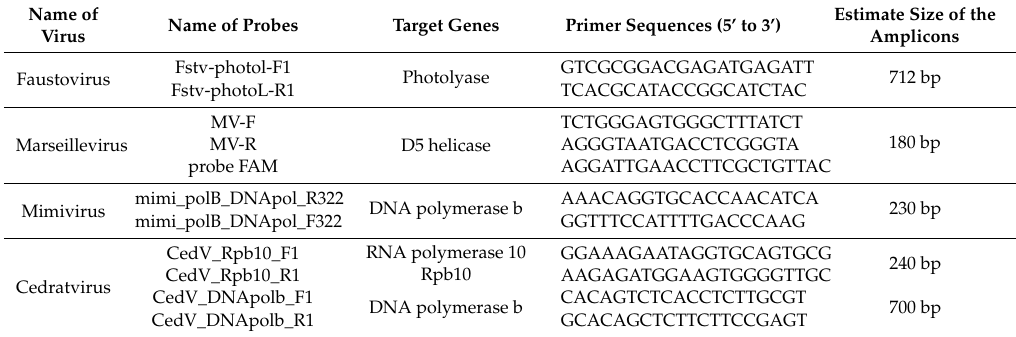
Table 2. Primer and probe sequences used for